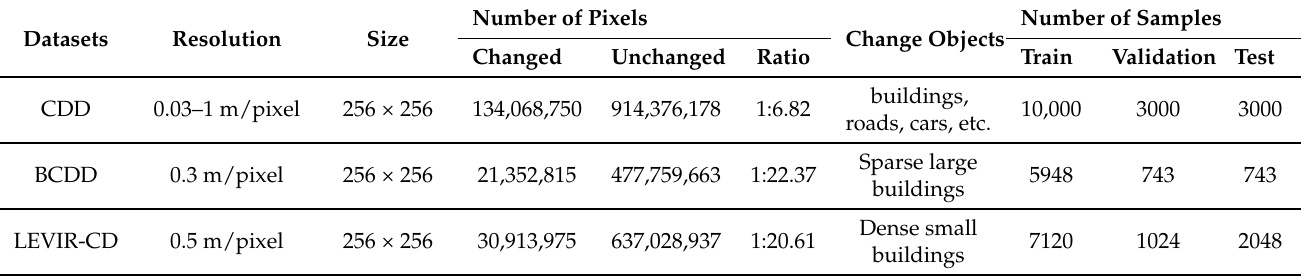
Table 2. Main indicators of the three dataset we